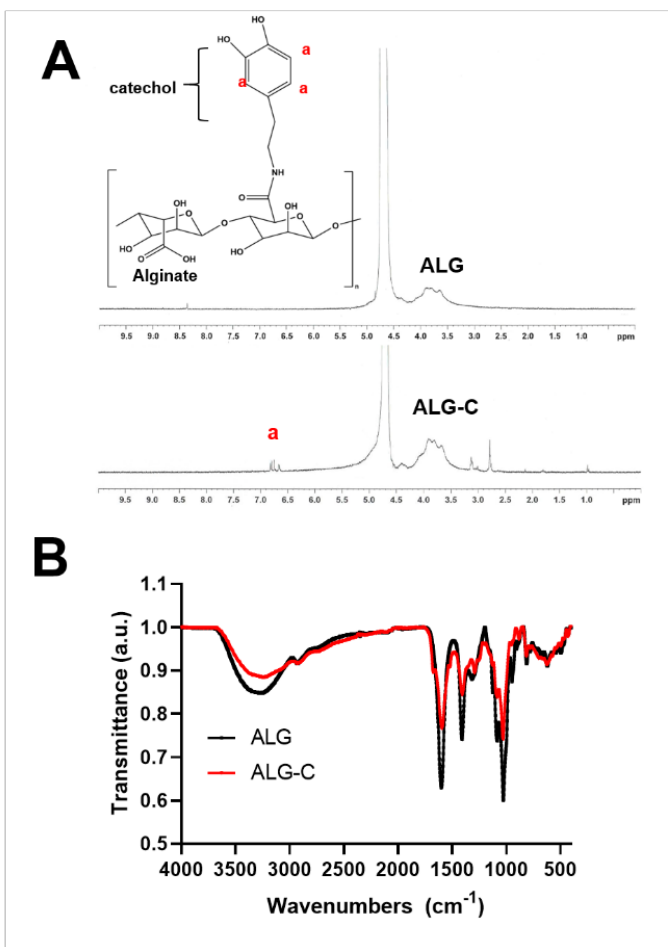
Figure 2. Detection of catechol moiety on ALG-C by 1 H NMR and ATR-FTIR. ( A ) The chemical shift of two H at the ortho-position and meta-position represented around 6.5 ppm and 6.9 ppm, respectively. ( B ) The ATR-FTIR spectra showed the successful conjugation of catechol onto the alginate backbone.